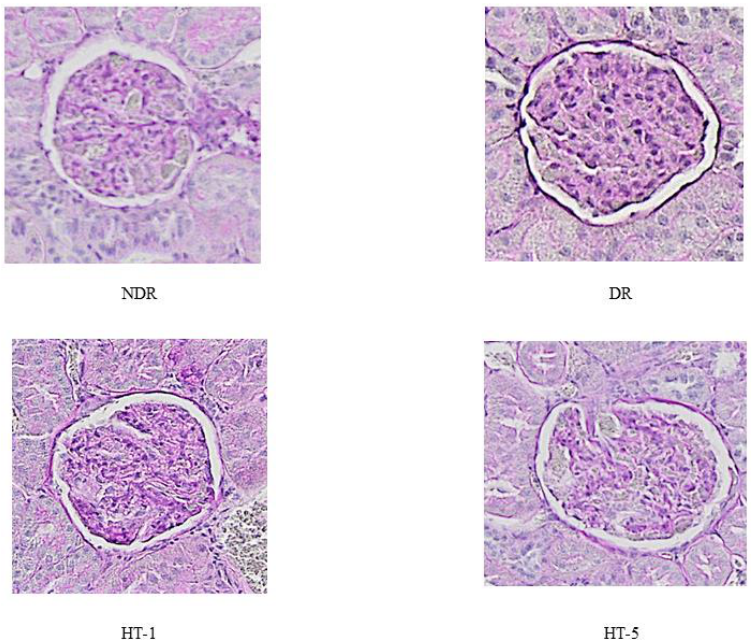
Figure 4. Representative examples of glomerular images from control nondiabetic rats (NDR), control diabetic rats (DR), and DR treated with hydroxytyrosol 1 mg/kg/day p.o. (HT-1) or 5 mg/kg/day p.o. (HT-5). PAS (×10).